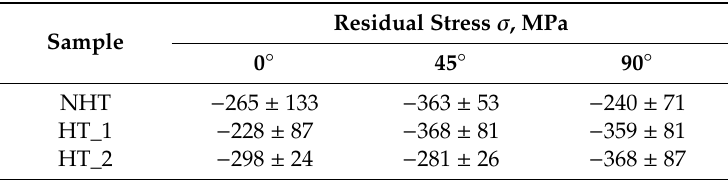
Table 5. Residual stress